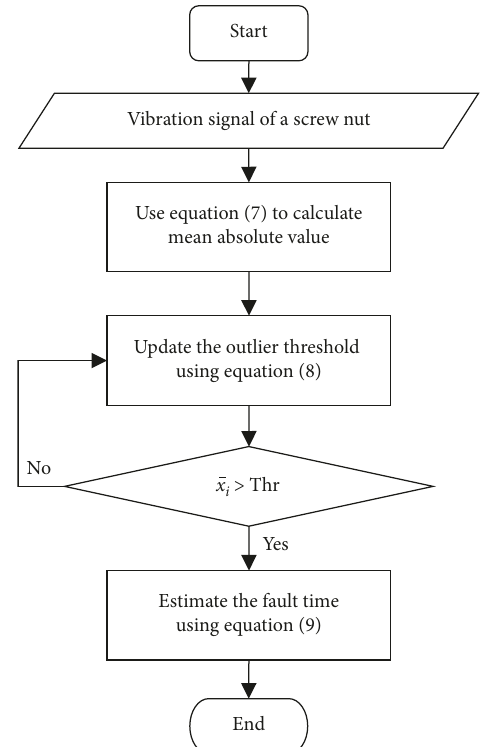
Figure 3: Flowchart of the proposed fault detection and fault time estimation method.